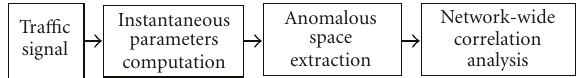
Figure 1: Distributed network tra ffi c anomaly detection